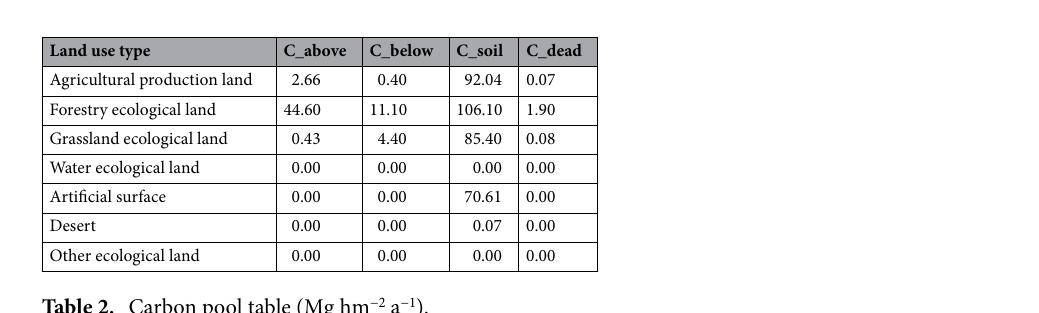
Table 2. Carbon pool table (Mg hm −2 a −1